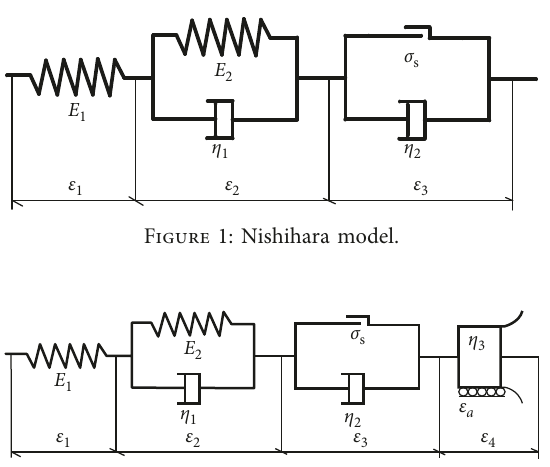
Figure 2: The modified Nishihara